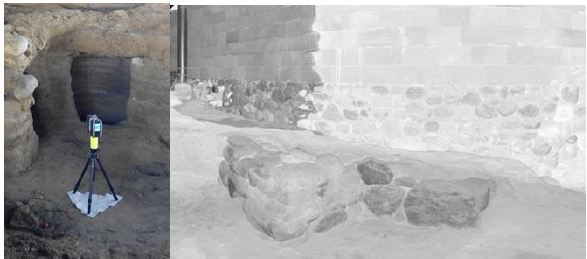
Figure 8. Data acquisition with the Faro-Focus3D 120 (Left) and the corresponding range image obtained (Right).